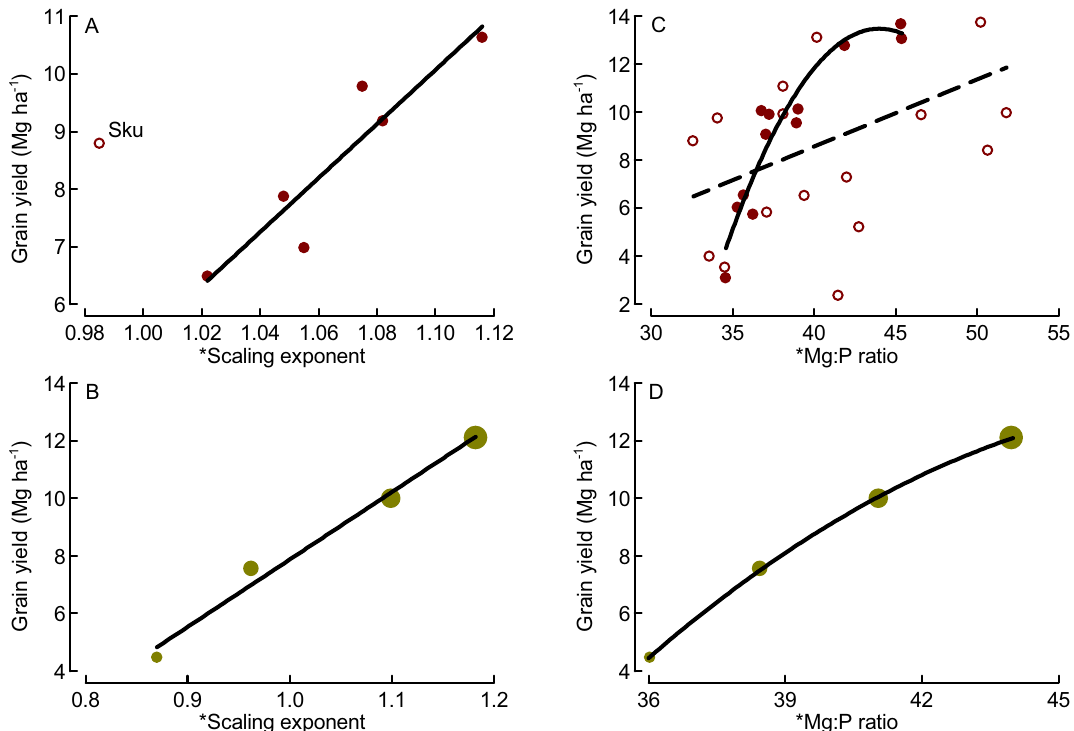
Figure 7. Mean winter wheat grain yields as function of scaling exponent for macroelements ( A , B ) and Mg:P ratio ( C , D ) plotted for various locations in Southern and Central Sweden ( A , C ) or across different fertilization levels at the same locations ( B , D ; increasing symbol size indicates increasing fertilizer level i.e. 0, 80, 160 and 240 kg N ha −1 ) based on the original data by Hamnér et al. (2017) 19 . * indicates that scaling exponents were based on data from stem elongation (BBCH37) and flowering (BBCH65) 35 . Regressions: y = 46.92x − 41.55, N = 6, R 2 = 0.86, P = 0.007; the data point for the location “Skultuna” ( Sku ) was not considered in the regression ( A ); y = 23.404x − 15.530, N = 4, R 2 = 0.98, P < 0.001 ( B ); y 1 = 0.28x − 2.64, N = 28, R 2 = 0.21, P = 0.015 (all data, C, broken line ) and y 2 = − 0.103 × 2 + 0.777x − 20.87, N = 12, R 2 = 0.90, P < 0.001 (only data from the locations Grillby, Nybble and Strömsholm, C, solid line ) ( C ); y = − 0.052x 2 + 5.126x − 112.51, N = 4, R 2 = 1.00, P = 0.016 ( D ). Dots represent means of 4 fertilization treatments and 4 replicates (A), 7 locations and 4 replicates (B, D) or 4 replicates